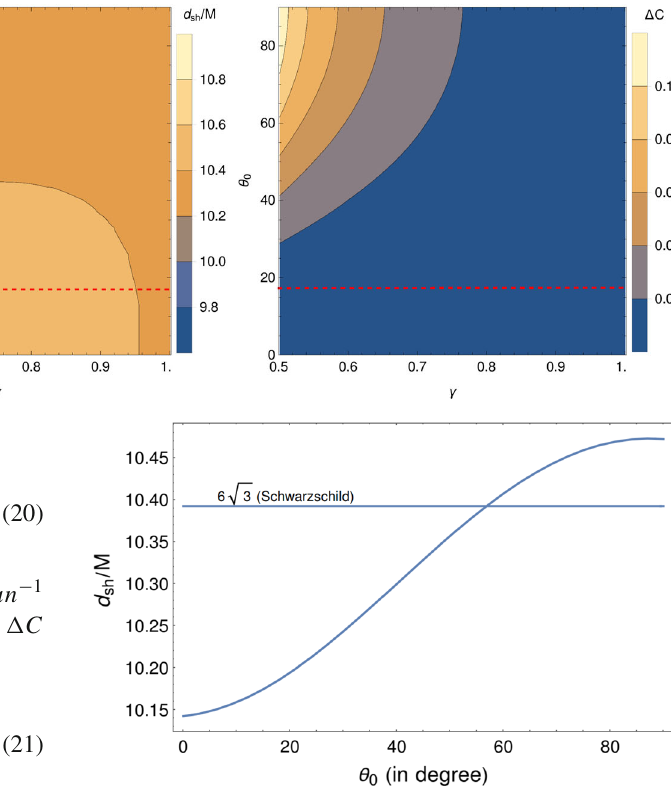
Fig. 6 The diameter of the shadow for the GI spacetime